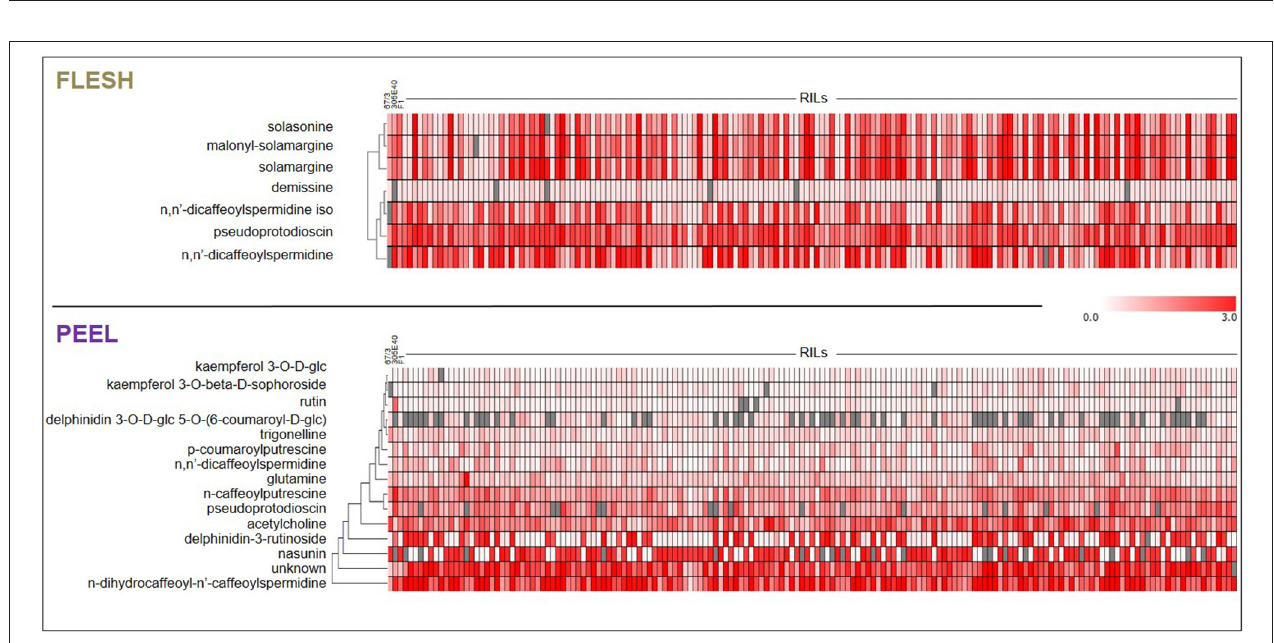
FIGURE 6 | Heat-maps representing levels of accumulation of differentially metabolites in flesh and peel extracts. Metabolites were subjected to Hierarchical Clustering Analysis (HCA). Color coding represents the average signal intensity (fold/ISTD) in individual lines.